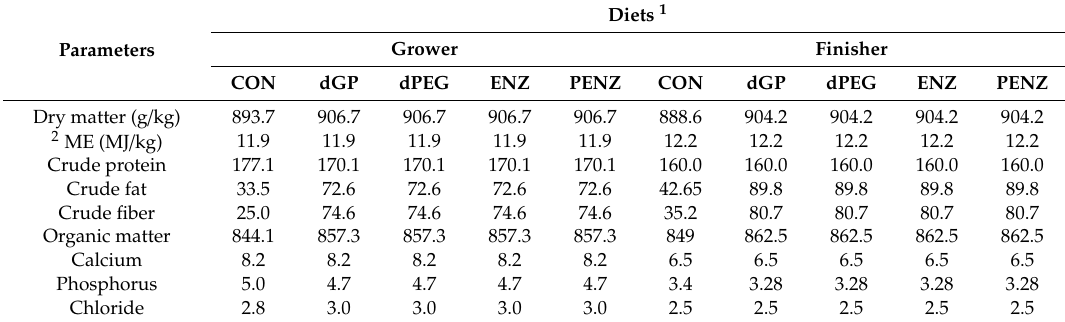
1 Diets: CON = commercial chicken diet without red grape pomace; dGP = commercial chicken diet containing 100 g / kg untreated red grape pomace; dPEG = commercial chicken diet containing 100 g / kg red grape